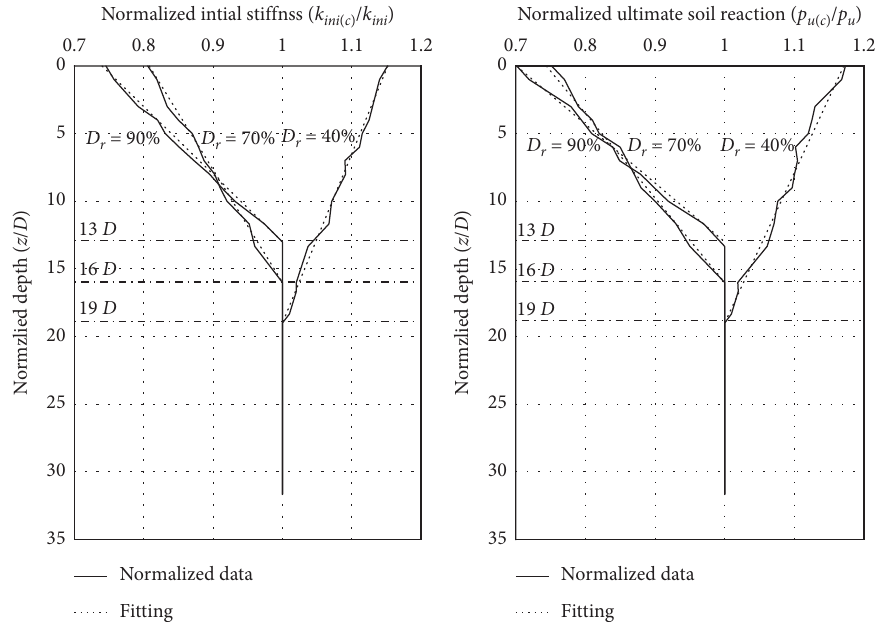
Figure 12: Normalized initial stifness and normalized ultimate soil reaction versus